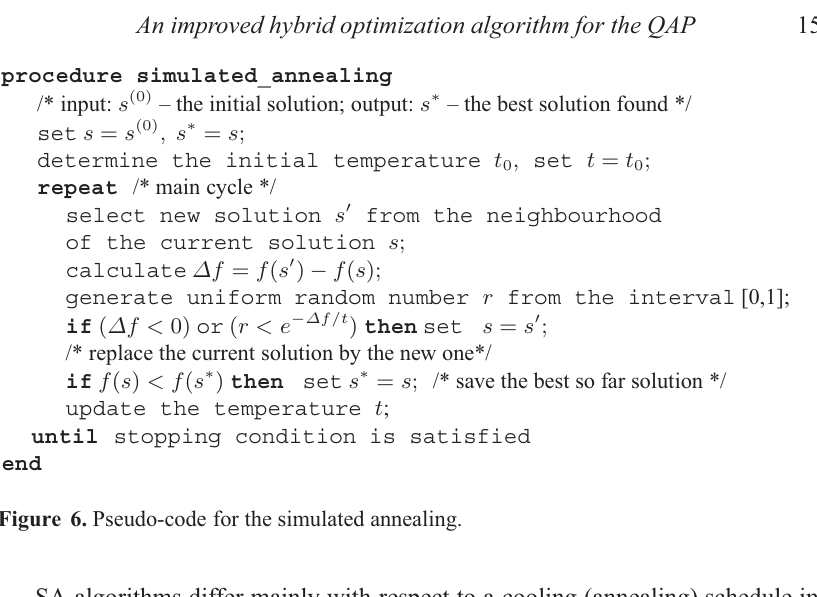
Figure 6. Pseudo-code for the simulated